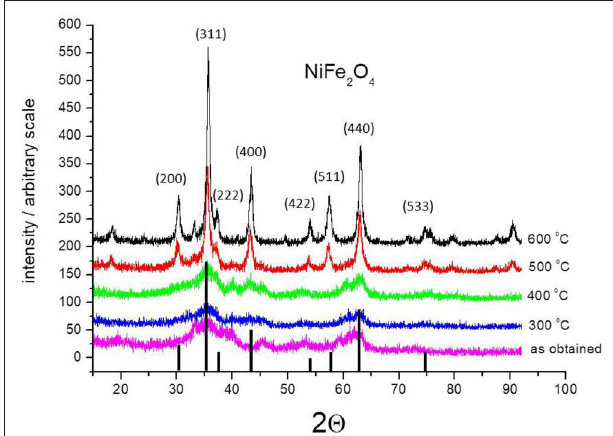
FIGURE 1 | XRD pattern of the as-prepared NiFe 2 O 4 nanoparticles as obtained and annealed at different temperatures. The figure includes the standard XRD pattern for nickel ferrite (ICDD file No. 44-1485).